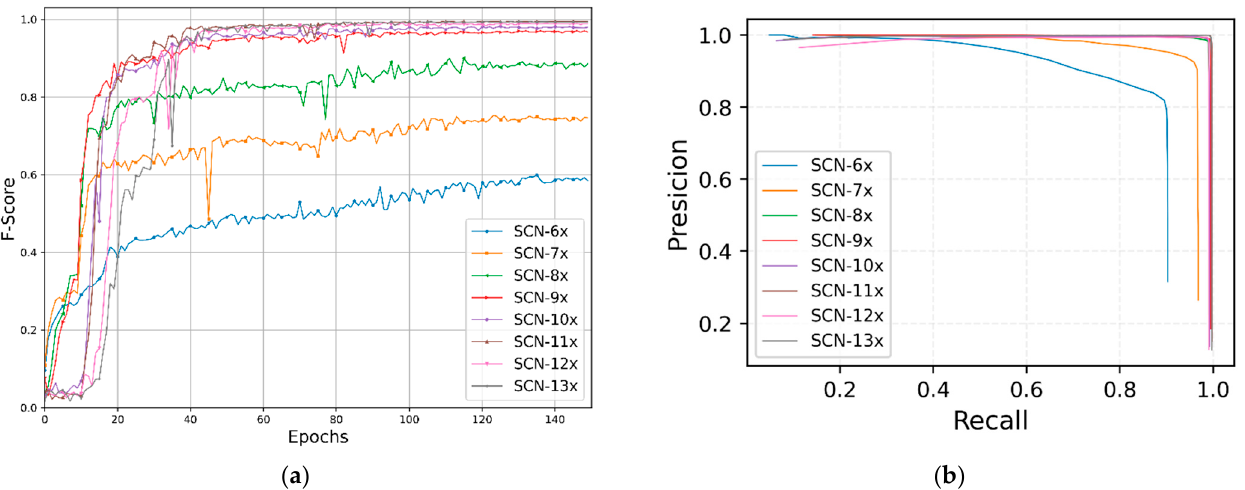
Figure 8. The performance comparison of different scales of SCN. ( a ) F-scores change with training epochs. ( b ) PR curve.